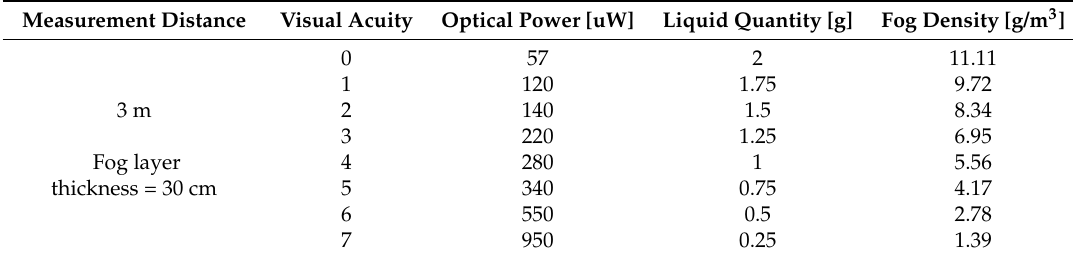
Table 4. Parallel between loss of optical power and visual acuity for different amounts of fog in a layer of fog of 30 cm and observation of the table from 3 m.